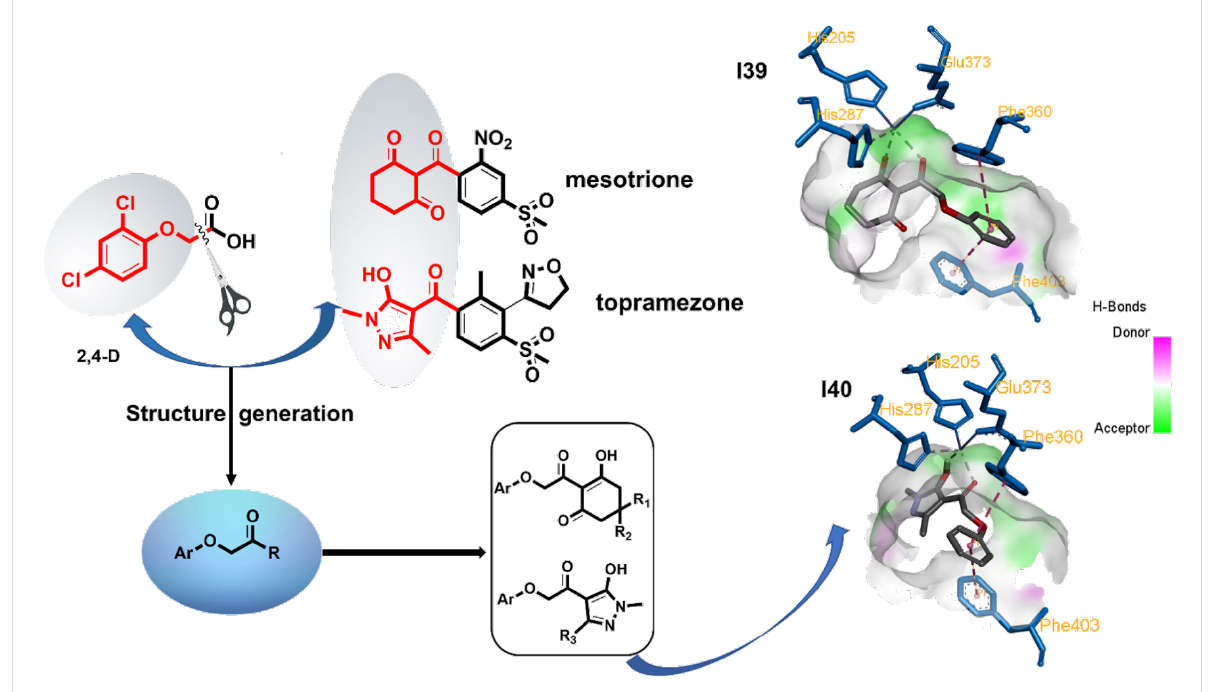
Figure 2: The design strategy of aryloxyacetic acid derivatives as HPPD inhibitors and simulate the binding modes of compound I39 and I40 in a target enzyme ( At HPPD). The key residues in the active site are shown in blue sticks, the Fe II is shown as a dark blue sphere, and compound I39 and I40 is shown in gray